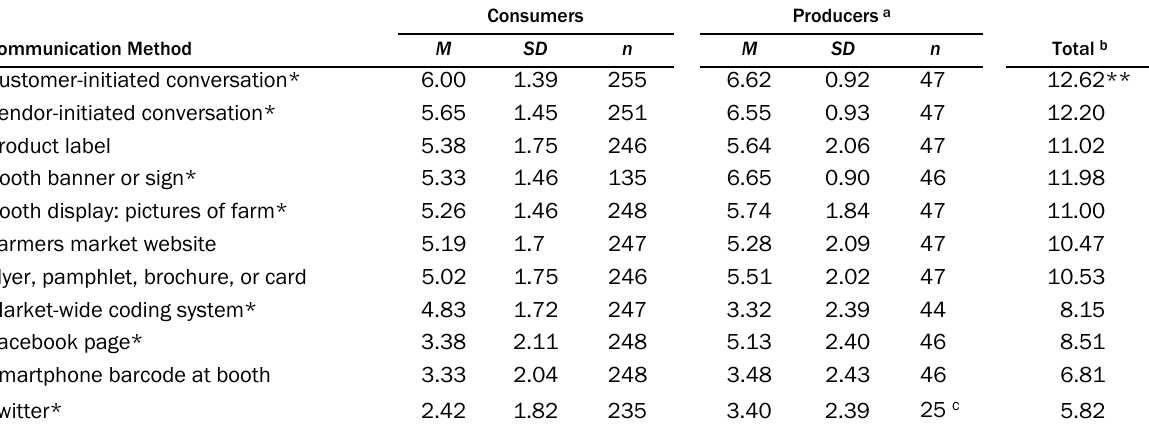
Table 5. Mean Ratings of Desired Communication